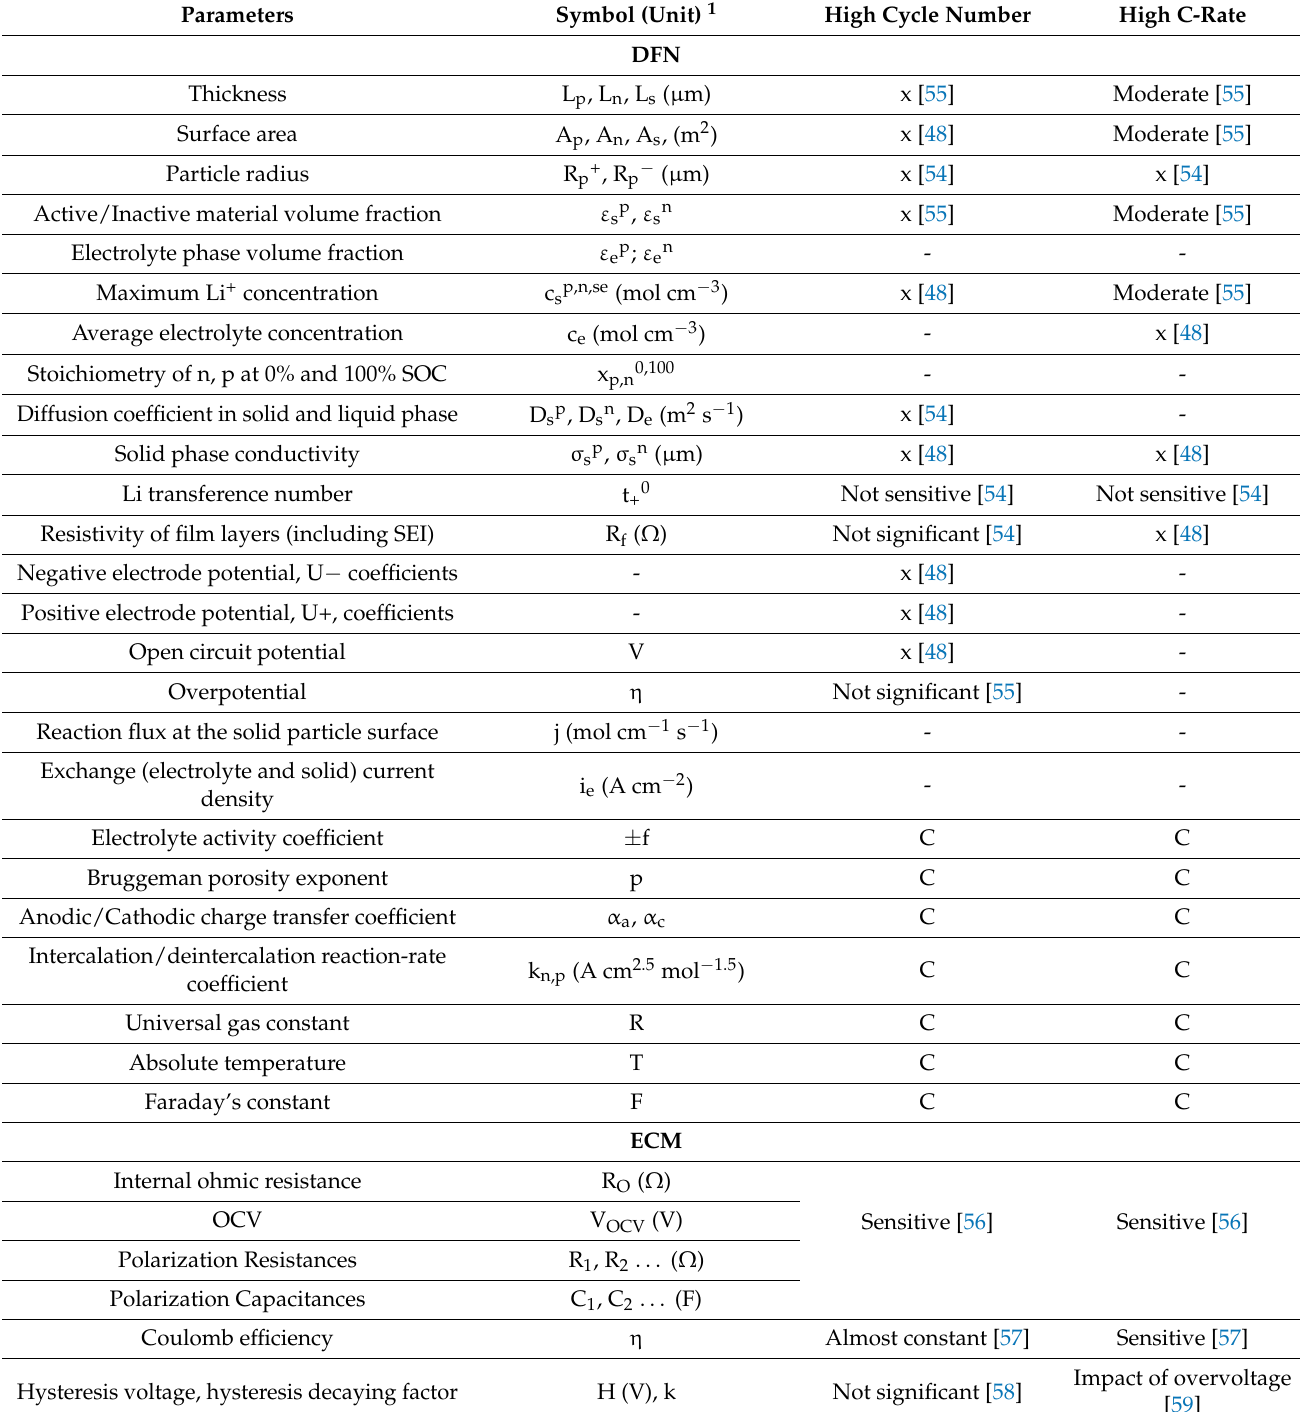
Table 2. Impact analysis of model parameters vs. battery degradation factors based on [48,54,55]. Legend for the table: x —impact identified in the reference article, but the impact level is not specified; C —Constants; Text —impact level identified by the reference article; Blank (-) —No direct information found on the sensitivity or dependency for this